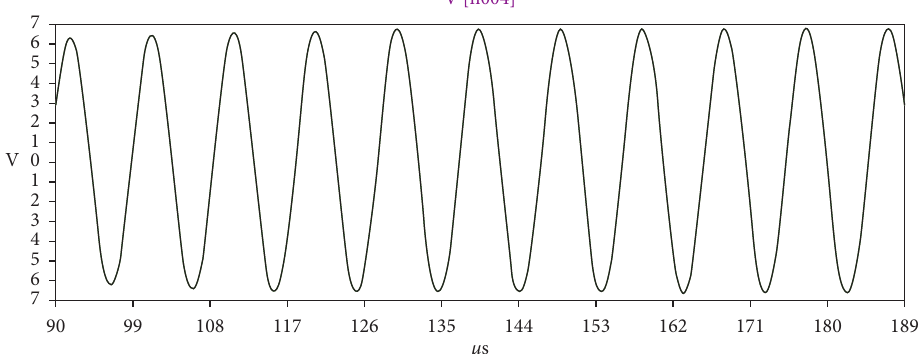
Figure 18: Oscillator frequency output-100 kHz.